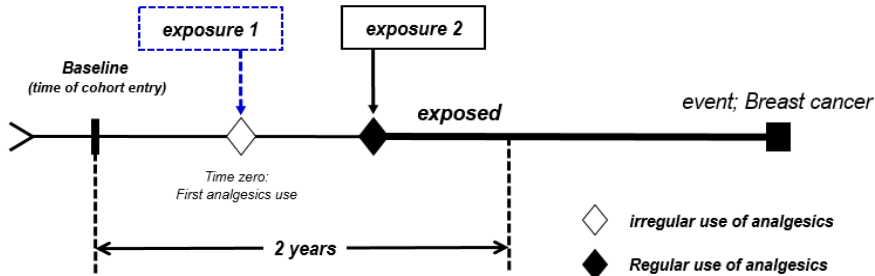
Figure 3. Study design including follow-up period from cohort entry to event occurrence.